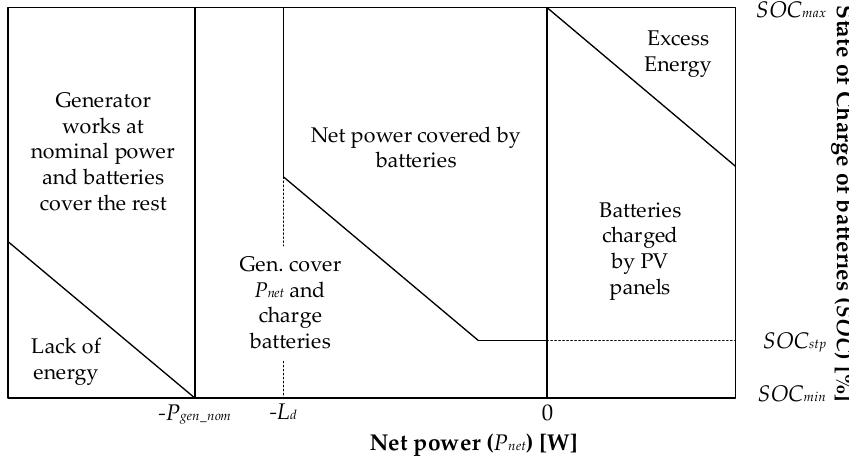
Figure 12. Simplified diagram of “cycle charging-frugal- SOC setpoint” strategy [140].